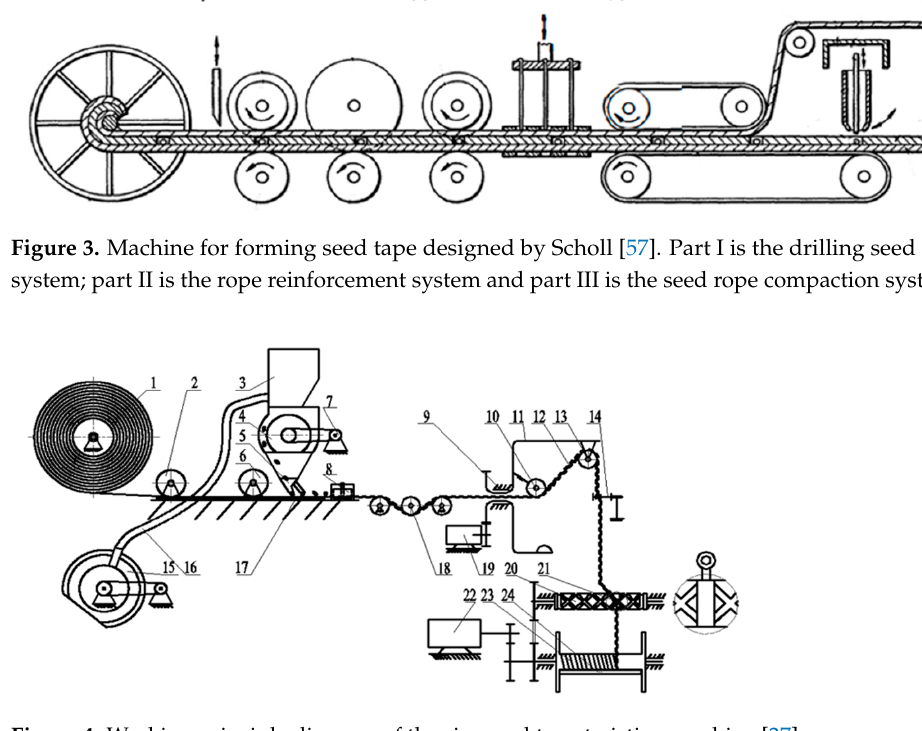
Figure 4. Working principle diagram of the rice seed tape twisting machine [27].